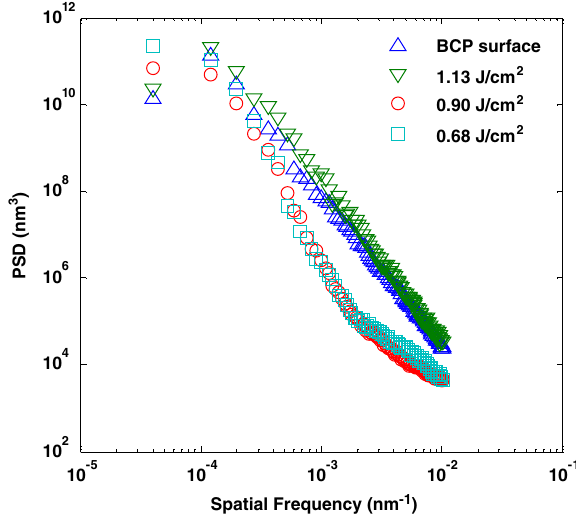
FIG. 6. PSD of the AFM data corresponding to Fig.